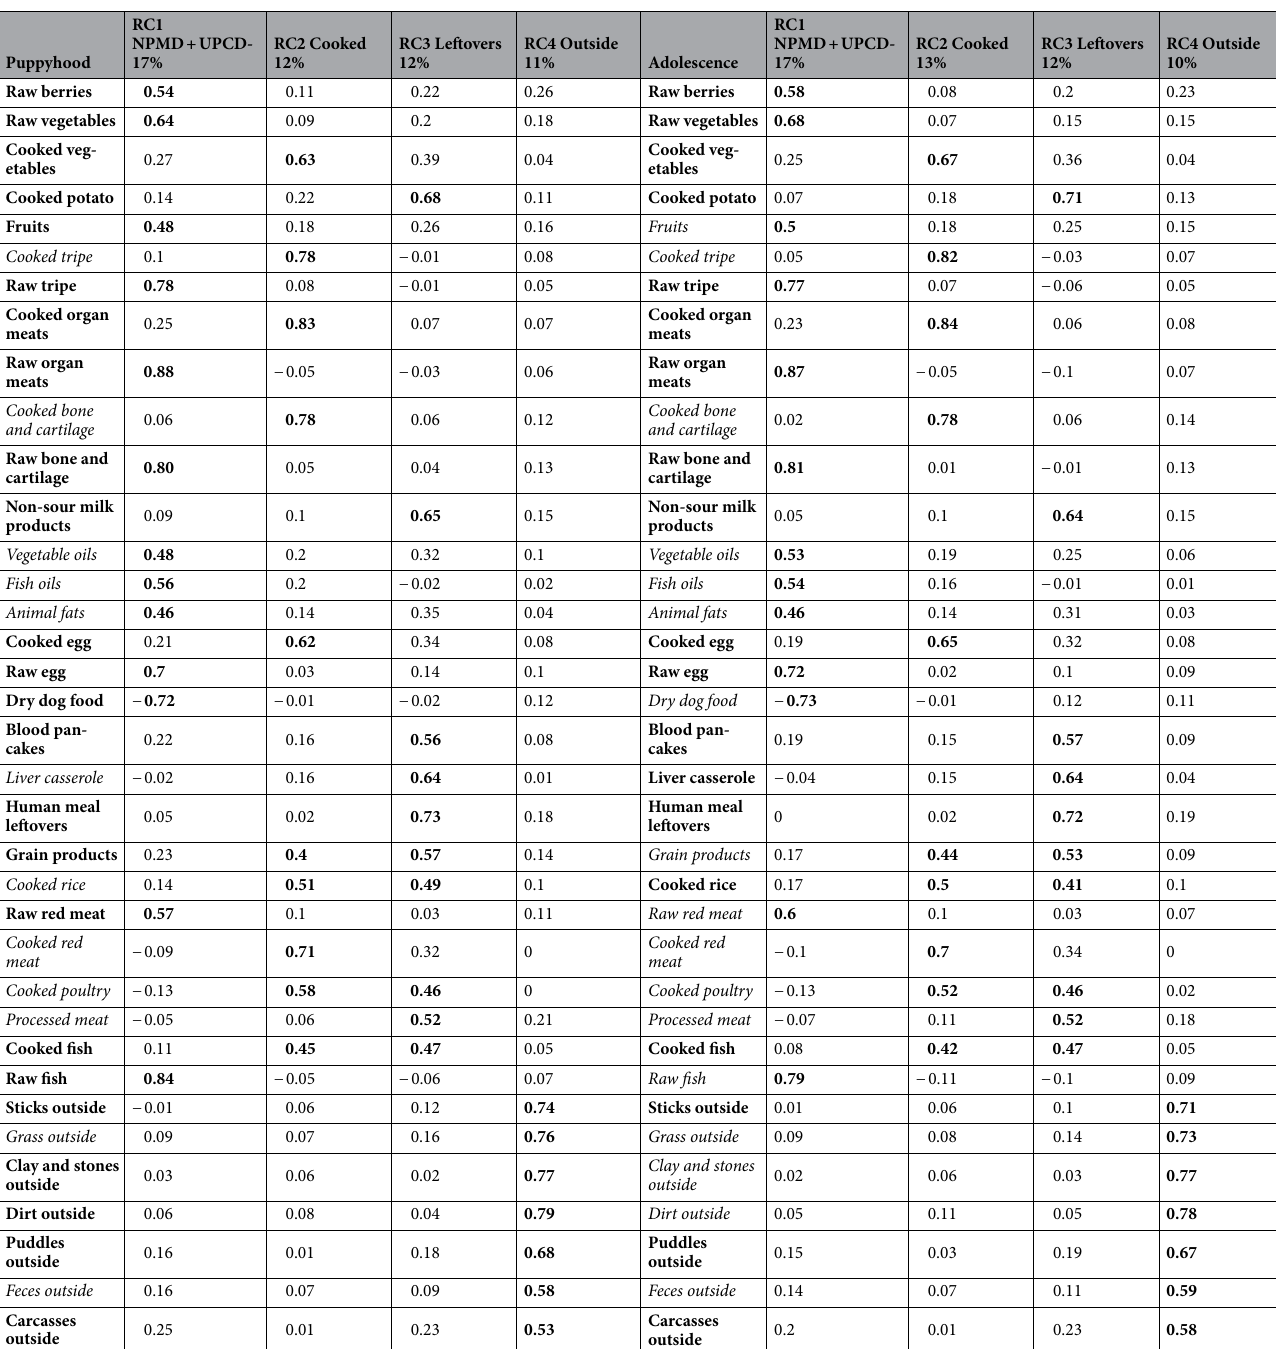
Table 2. Food items’ loadings to PCA components showing puppyhood (PU) and adolescent (YO) diet style. Variables that were significantly different (Mann Whitney U-test p < 0.05) between controls and CE cases in the preliminary screening are in bold. Loadings ≥ |0.4| are in bold. NPMD = non-processed meat-based diet, UPCD = ultra-processed carbohydrate-based diet, Cooked = home-cooked diet, Leftovers = human meal leftovers and table scraps, Outside = items eaten outside. Percent of variation explained is shown for each